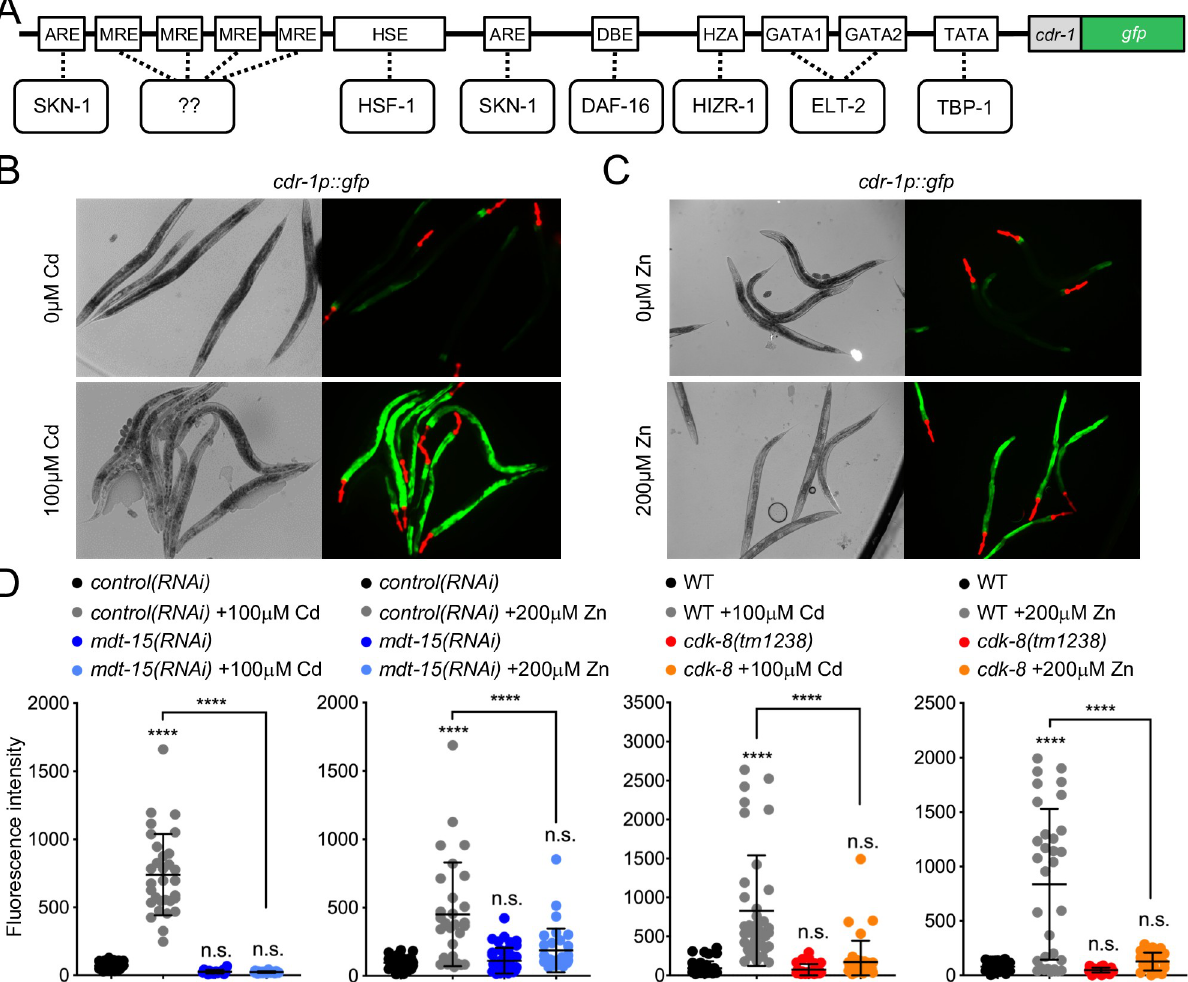
Fig 2. The cdr-1p :: gfp transcriptional reporter is induced by 100 μ M cadmium and 200 μ M zinc in cdk-8– and mdt-15 –dependent fashion. [A] Illustration of the cdr-1p :: gfp reporter and putative regulatory DNA elements in the cdr-1 promoter; note, the diagram is not to scale. For details, see text. [B, C] Representative micrographs of worms bearing the cdr-1p :: gfp and myo-2p :: mCherry (transgenic marker) transcriptional reporters, without and with exposure to [A] 100 μ M cadmium and [B] 200 μ M zinc. [D] The graphs show the average fluorescence intensity (arbitrary units, A.U.) of worms bearing the cdr-1p :: gfp transcriptional reporter. The two panels on the left show WT worms bearing the cdr-1p :: gfp transcriptional reporter fed either control or mdt-15 RNAi and exposed for four hours to 0 μ M or 100 μ M Cd or 0 μ M or 200 μ M Zn (control RNAi 0 μ M Cd: n = 32 worms total from 3 independent repeats; control RNAi 100 μ M Cd: n = 31 worms total from 3 independent repeats: mdt-15 RNAi 0 μ M Cd: n = 19 worms total from 3 independent repeats; mdt-15 RNAi 100 μ M Cd: n = 32 worms total from 3 independent repeats; control RNAi 0 μ M Zn: n = 30 worms 3 total from independent repeats; control RNAi 200 μ M Zn; n = 29 worms total from 3 independent repeats; mdt-15 RNAi 0 μ M Zn: n = 42 worms total from 3 independent repeats: mdt-15 RNAi 200 μ M Zn: n = 33 worms total from 3 independent repeats). The two panels on the right show WT and cdk-8 (tm1238) worms exposed for four hours to 0 μ M or 100 μ M cadmium (Cd) or 0 μ M or 200 μ M zinc (Zn) (WT 0 μ M Cd: n = 39 worms total from 3 independent repeats; WT 100 μ M Cd: n = 39 worms total from 3 independent repeats; cdk-8(tm1238) 0 μ M Cd: n = 29 worms total from 3 independent repeats; cdk-8(tm1238) 100 μ M Cd: n = 38 worms total from 3 independent repeats; WT 0 μ M Zn: n = 31 worms total from 3 independent repeats; WT 200 μ M Zn: n = 32 worms total from 3 independent repeats; cdk-8(tm1238) 0 μ M Zn: n = 31 worms total from 3 independent repeats; cdk-8(tm1238) 200 μ M zinc: n = 24 worms total from 3 independent repeats). Error bars: standard deviation. Statistical analysis: ���� p < 0.0001, n.s. = not significant, two-way ANOVA, multiple comparisons, Tukey correction; comparisons are to WT or control(RNAi) unless indicated by lines.